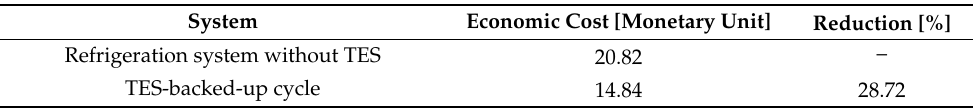
Figure 15. Temperature of the intermediate fluid and the cylindrical layers within the PCM cylinders. ( a ) Temperature of the TES tank intermediate fluid. ( b ) Distribution of temperature field within the PCM cylinders. Table 5. Economic cost comparison of the proposed scheduling strategy for the TES-backed-up cycle and the original system without